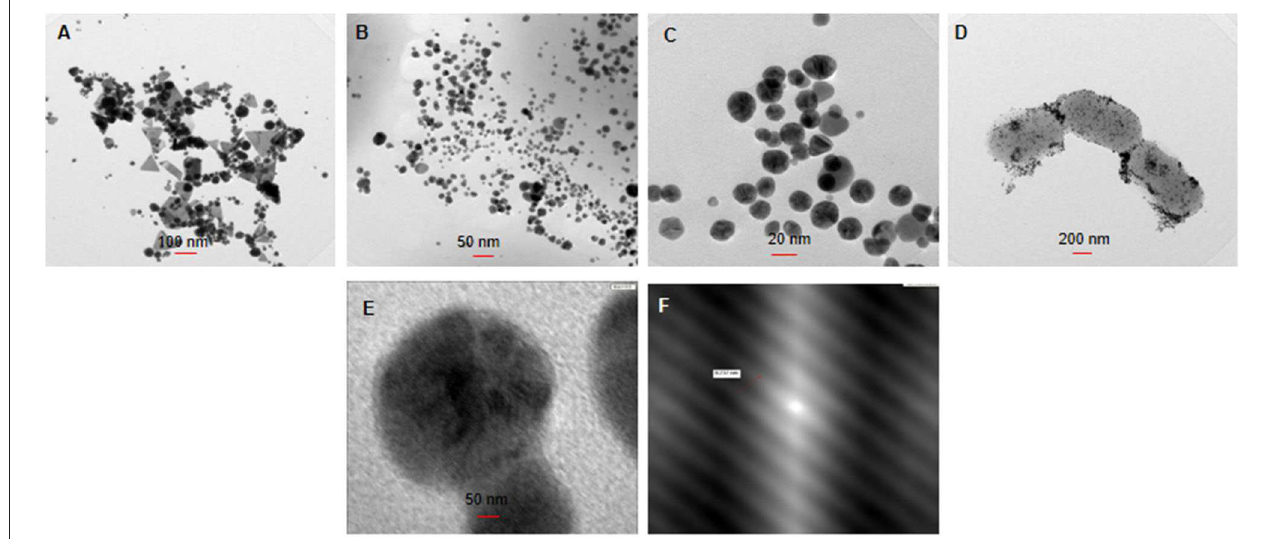
FIGURE 3 | Transmission electron microscopy for the synthesis of AuNPs, using (A,B) 1 and 0.5mM of HAuCl 4, respectively, (C,D) at 37 and 50 ◦ C, (E) enlarged image of optimized AuNPs, and (F) lattice and fringes on